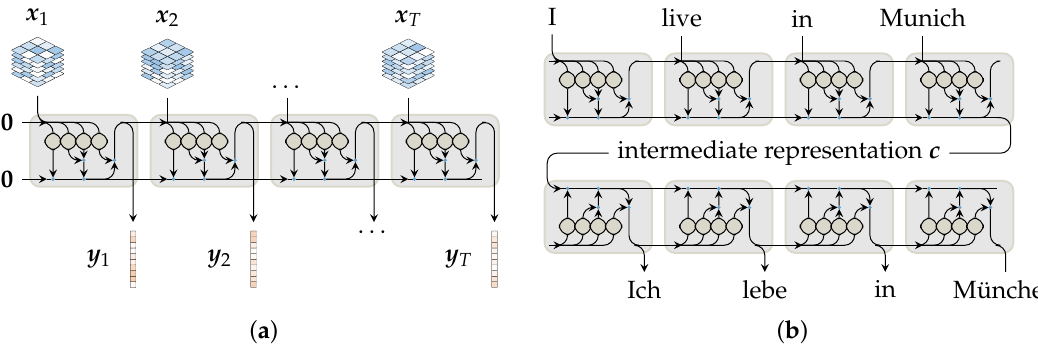
(b) Illustration of a sequence-to-sequence network [8] as often used in neural translation tasks. Figure 2. Illustrations of recurrent network architectures that inspired this work. The network of Figure 2. Illustrations of recurrent network architectures which inspired this work. The network of previous work [28] shown in ( a ) creates a prediction y t at each observation t based on spectral input previous work [28] shown in Figure 2(a) creates a prediction y t at each observation t based on spectral information x t and the previous context h t 1 , c t 1 . Sequence-to-sequence networks, as shown in ( b ), − − input information x t and the previous context h t aggregate sequential information to an intermediate state c T , which is a representation of the entire 1 , c t 1 . Sequence-to-sequence networks, as shown in − − Figure 2(b), aggregate sequential information to an intermediate state c T which is a representation of series. ( a ) Network structure employed in previous work [28]; ( b ) illustration of a sequence-to-sequence the entire series. network [8] as often used in neural translation